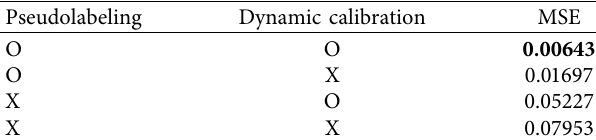
Table 5: Mean squared error of testing models.